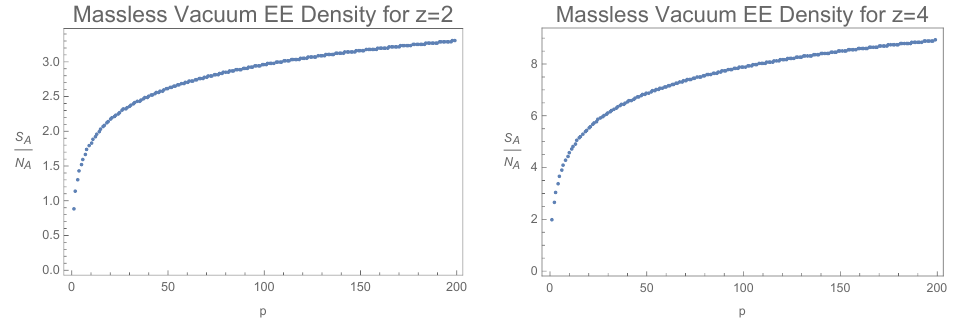
Figure 5: Vacuum EE density of z = 2 and z = 4 Lifshitz theories as a function of p with J = 0, or equivalently, m = 0. The vacuum EE density increases without bounds as p